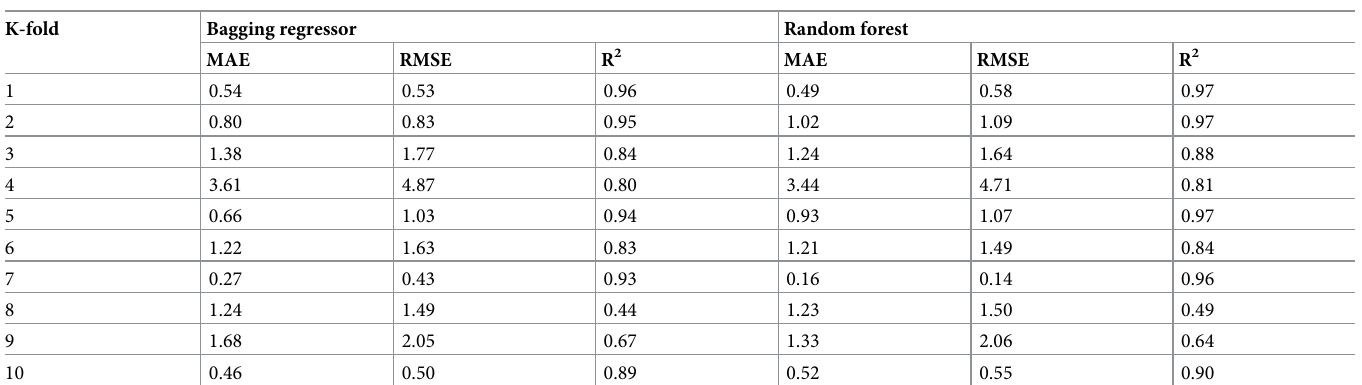
Table 2. Results of the k-fold validation method.